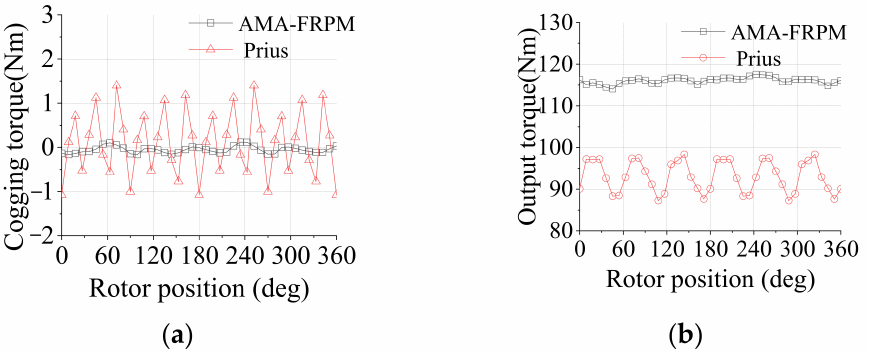
Figure 20. Torque performances of AMA-FRPM and Prius machines. ( a ) Cogging torque. ( b ) Output torque.